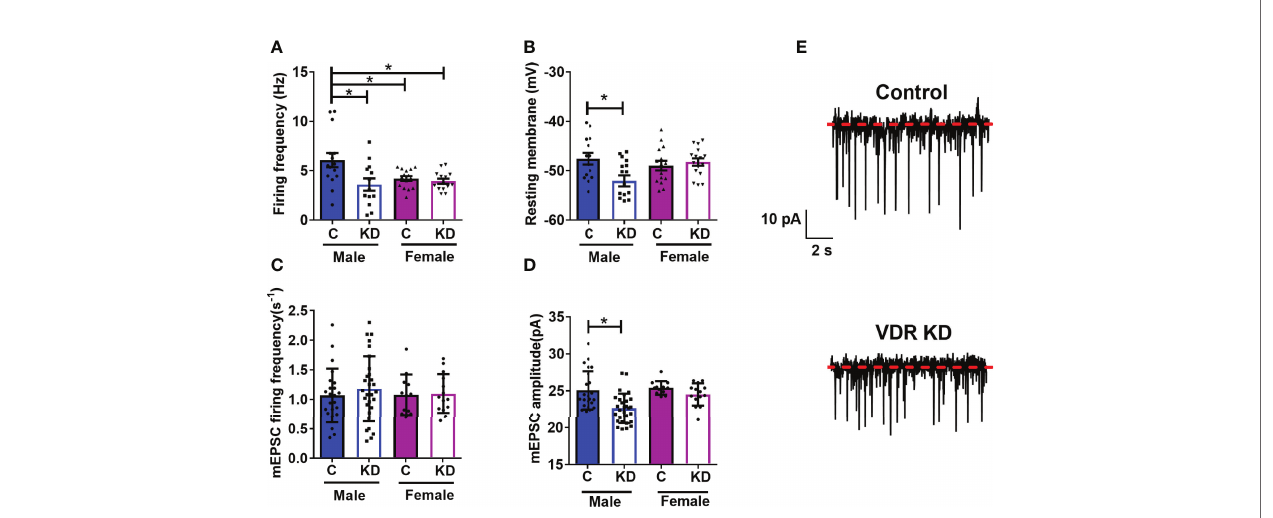
FIGURE 3 | PVH VDR loss decreases neuronal activity in male but not female mice. (A) Firing frequency in male and female control VDR +/+;Sim1-cre;TOMATO ( “ C ” ) and PVH VDR knockdown VDR f/f;Sim1-cre;TOMATO ( “ KD ” ) mice. (B) Resting membrane potential. (C) mEPSC fi ring frequency. (D) mEPSC amplitude. (E) Representative traces from male control and PVH VDR knockdown mice. *p<0.05 via one-way ANOVA. N=12-30